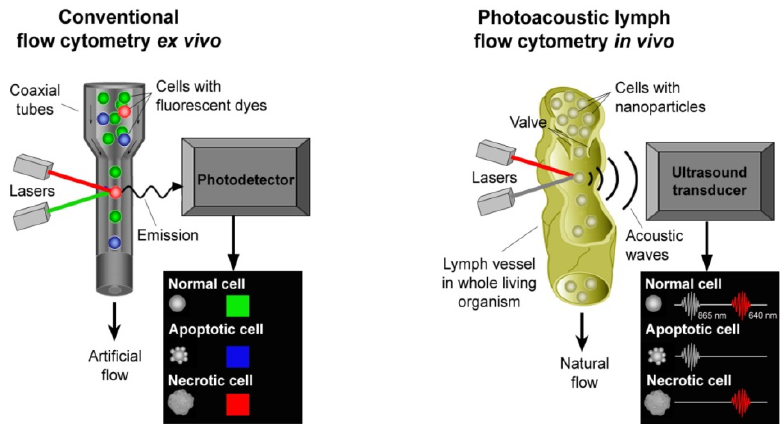
Figure 20. Comparison of conventional flow cytometry in vitro (left) and in vivo PA lymph flow cytometry (right) for detection of cells in different functional states.